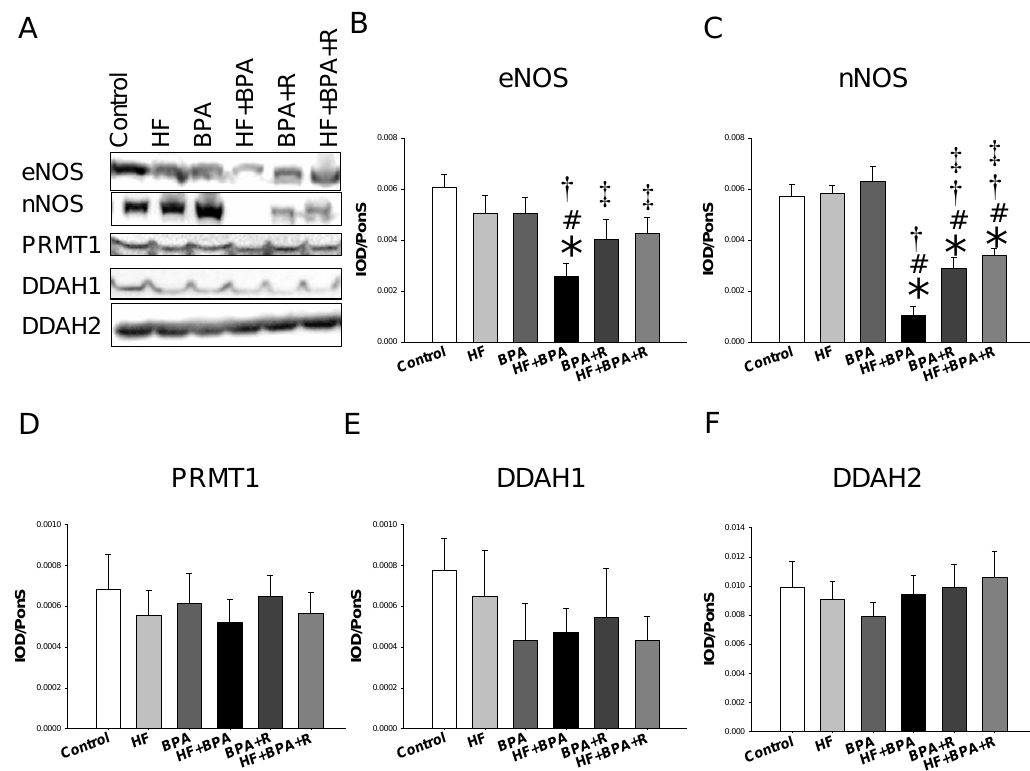
Figure 2. Representative Western blots ( A ) show the endothelial NO synthase (eNOS) (~150 kDa), the neuronal NO synthase (nNOS) (~160 kDa), PRMT1 (~42 kDa), DDAH-1 (~34 kDa), and DDAH-2 (~30 kDa) bands in the offspring kidneys at 16 weeks of age. Relative abundance of renal cortical ( B ) eNOS, ( C ) nNOS, ( D ) PRMT1, ( E ) DDAH1, and ( F ) DDAH2. n = 7–8 / group; * p < 0.05 versus control; # p < 0.05 versus HF; † p < 0.05 versus BPA; ‡ p < 0.05 versus HF + BPA.